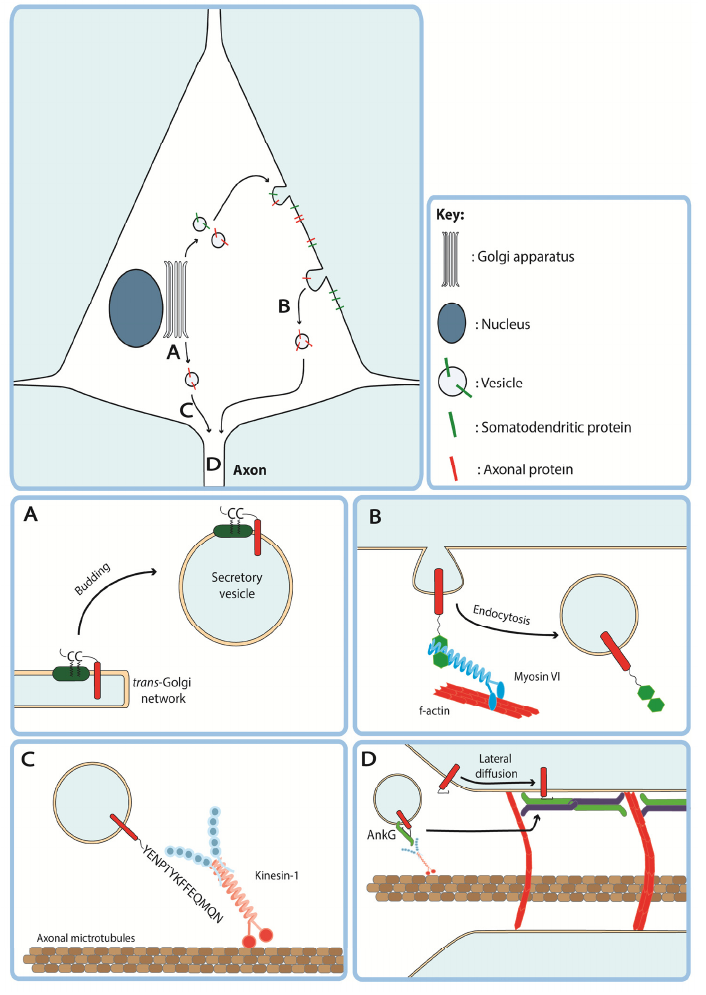
Figure 2. Axon-targeting motifs influence diverse steps in the secretory and transcytotic trafficking pathways of transmembrane proteins to the axonal compartment. ( A ) A dicysteine palmitoylation motif found in Paralemmin and GAP-43 promotes association with lipid rafts in the trans -Golgi network, sorting transmembrane proteins into axon-targeted secretory vesicles. ( B ) Fused myosin VI binding domains of optineurin and DAB2 promote endocytosis of transmembrane proteins from the somatodendritic membrane for transcytotic delivery to the axon. ( C ) The C-terminus of APP drives association with light chains of kinesin-1, promoting axonal entry and anterograde trafficking. ( D ) Ankyrin-G (AnkG) binding domains found in Nav1.6 and Kv3.1 promote localisation to the axon initial segment potentially via association with AnkG on kinesin-3 driven vesicles or by